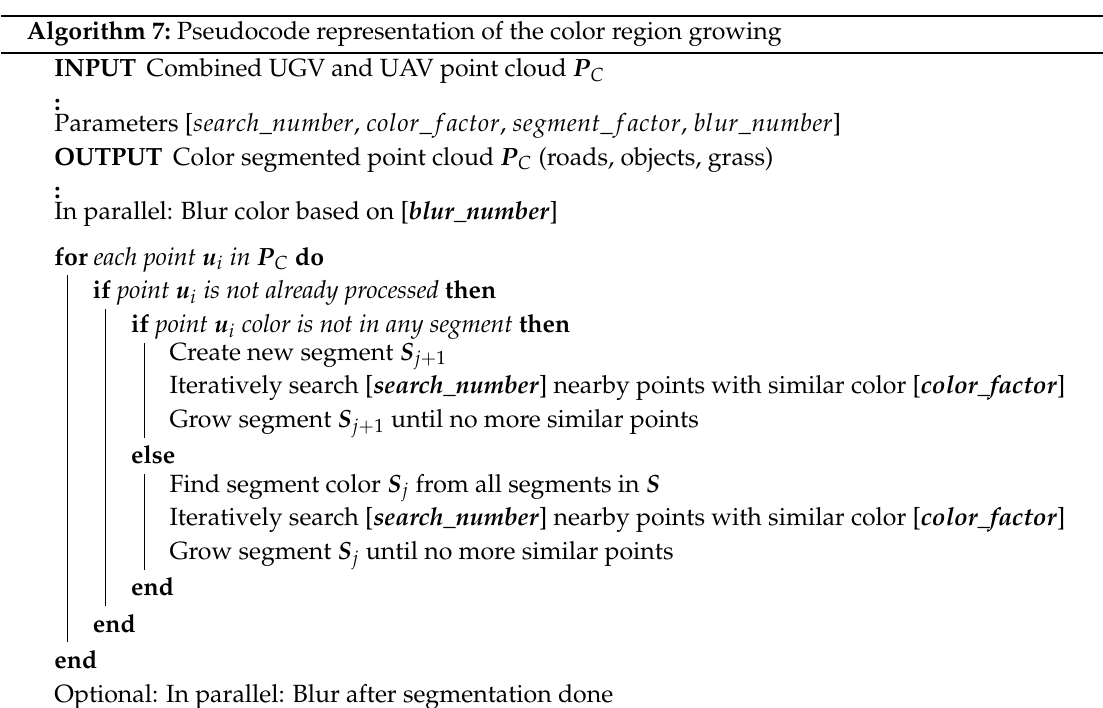
Algorithm 7: Pseudocode representation of the color region